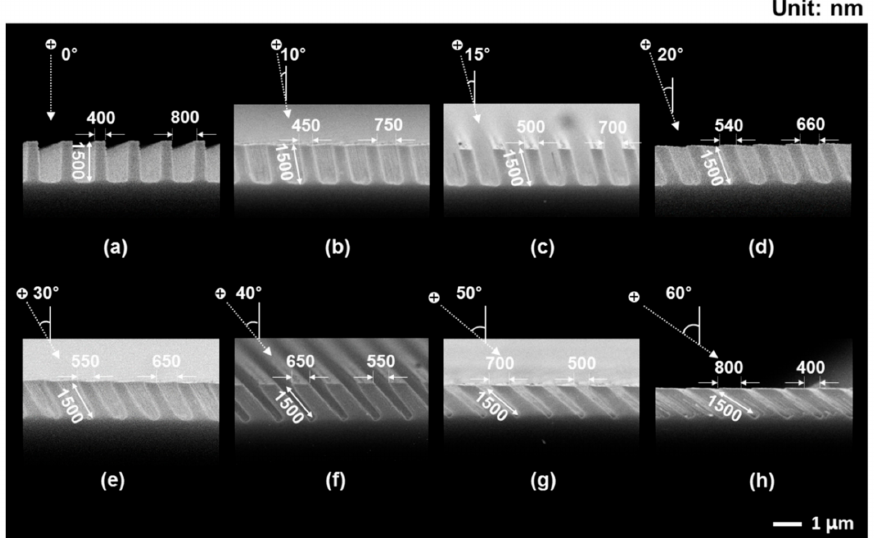
Figure 4. SEM images of Si substrates with periodically arrayed nanopillars at various ion-incidence angles: ( a ) 0 ◦ ; ( b ) 10 ◦ ; ( c ) 15 ◦ ; ( d ) 20 ◦ ; ( e ) 30 ◦ ; ( f ) 40 ◦ ; ( g ) 50 ◦ ; ( h ) 60 ◦ . The heights of the nanopillars were defined as the etch depth in the direction of the ion-incidence angle.